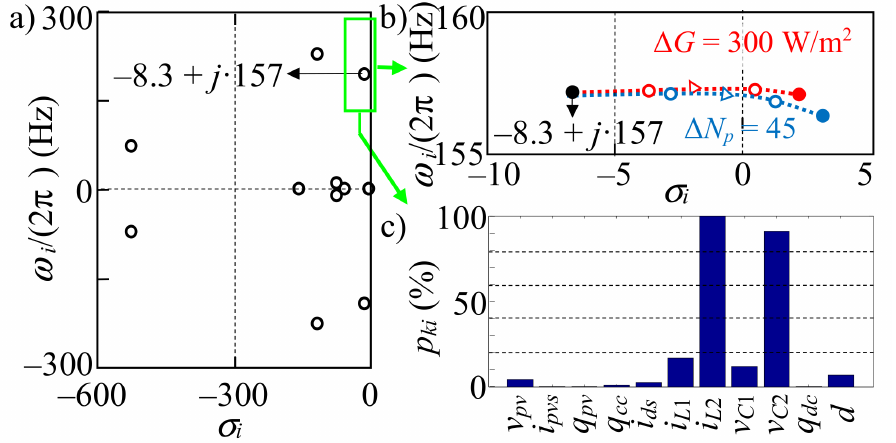
Figure 6. PV power system stability assessment: ( a ) case #1 eigenvalues; ( b ) trajectories of the eigenvalue related to instability for different G and N p ; ( c ) PFs of the eigenvalue related to instability in case